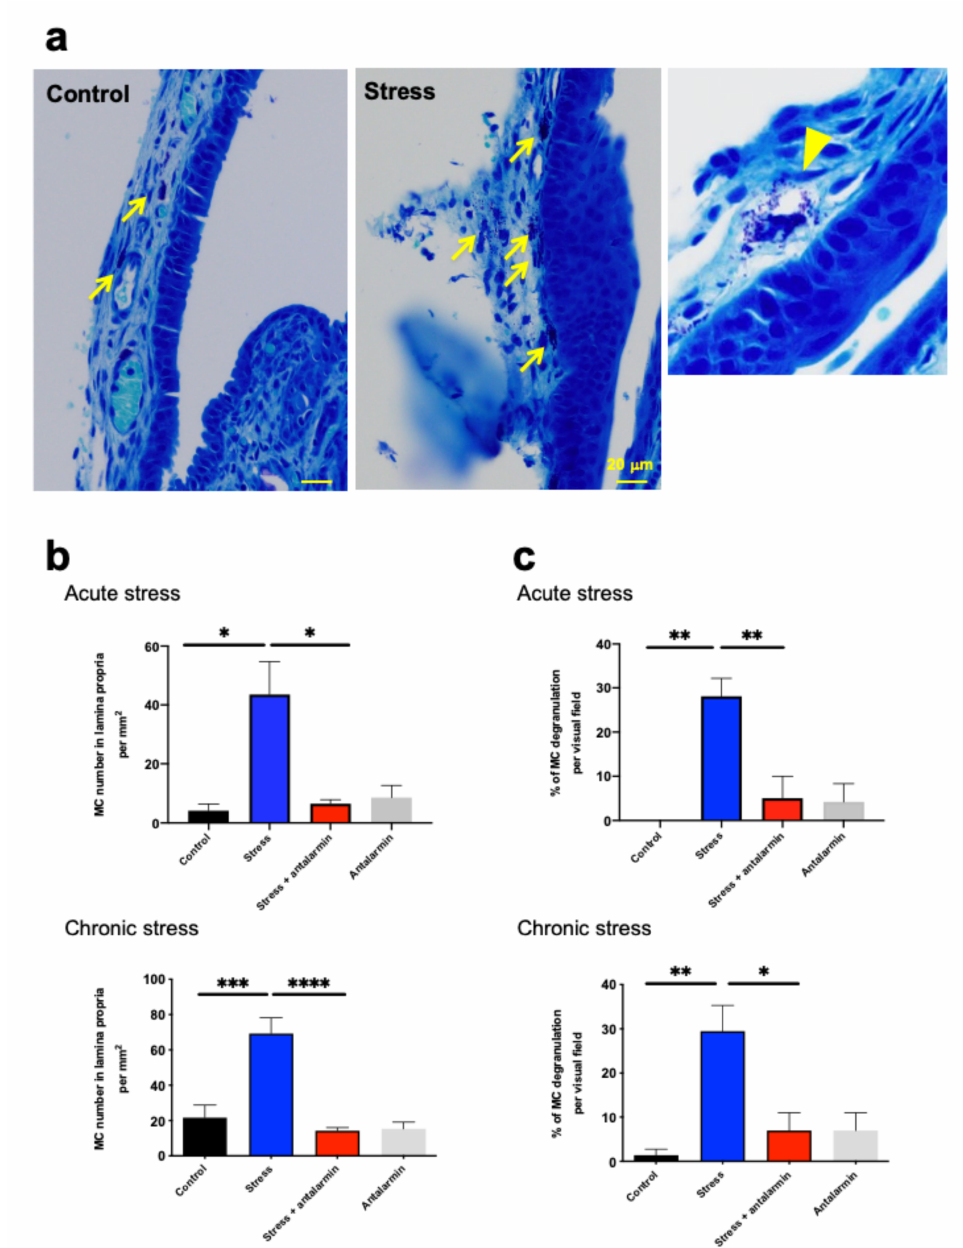
Figure 6. Restraint stress increased mice nasal mucosa MC (mM-MC) numbers and degranulation. ( a ) Toluidine blue histochemistry of murine nasal mucosa. The arrow denotes mM-MCs in the lamina propria, and the arrowhead denotes a degranulated mM-MC. Scale bar = 20 µ m. ( b ) Quantitative immunohistomorphometry of mM-MC. ( c ) The percentage of degranulated mM-MCs in the nasal mucosa after restraint stress and nasal application of antalarmin. Both acute and chronic restraint stress significantly increased mM-MC numbers in the nasal mucosa and stimulated their degranula- tion. The increased number of mM-MCs and their degranulation in stressed mouse nasal mucosa was significantly inhibited by nasal application of antalarmin. Control group, n = 4 (without stress); stress group, n = 4; stress + antalarmin (5 µ g/g/day) group, n = 5; and antalarmin group, n = 4 (without stress). Error bars indicate SEM. * p < 0.05, ** p < 0.01, *** p < 0.001, **** p < 0.0001. MC, mast cell; mM-MCs, mice nasal mucosa